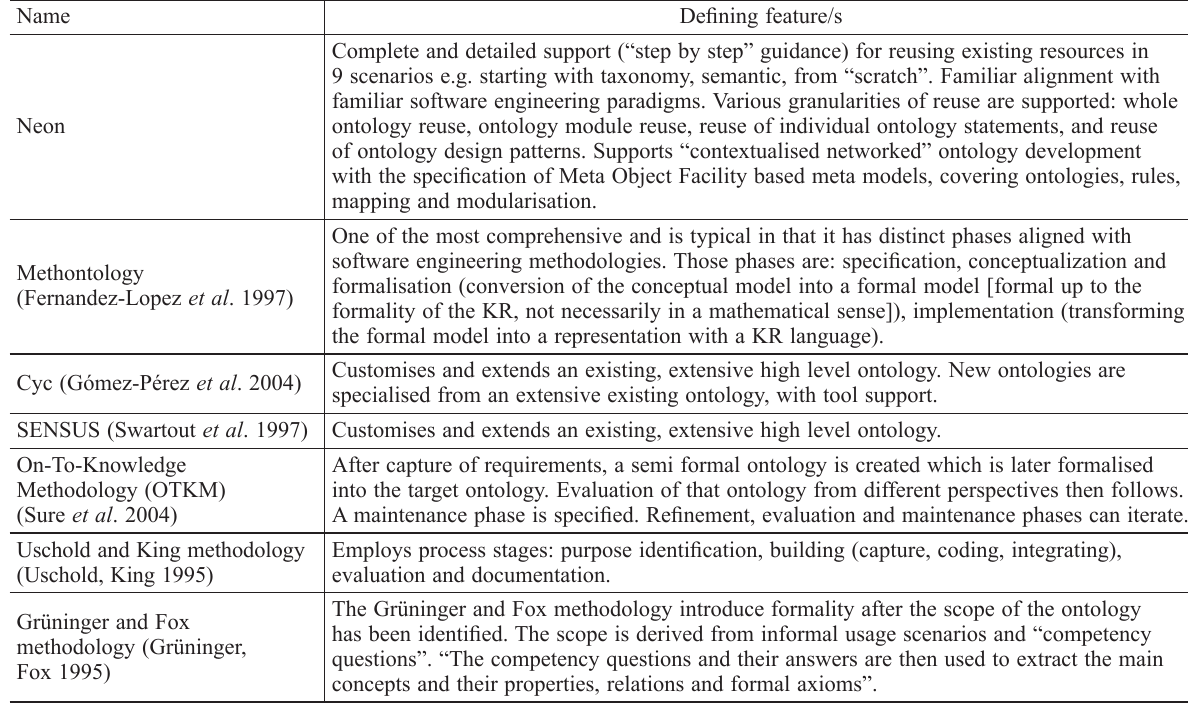
Table 2. Defining characteristics of selected ontology development